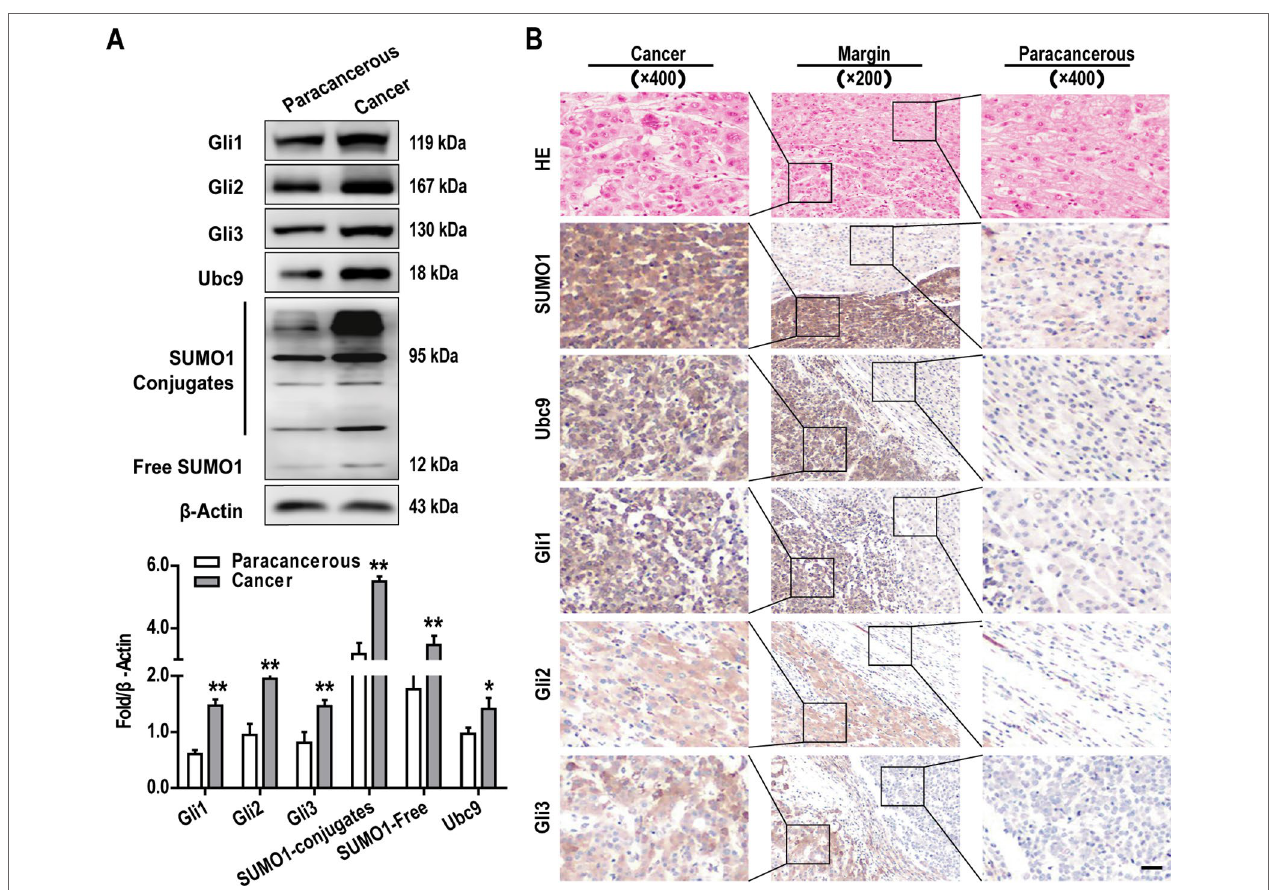
FIGURE 1 | Elevated GLI family proteins expression and extensive protein SUMO modification are characteristics of hepatocellular carcinoma (HCC) cells in vivo . Gli1-3, SUMO1, and Ubc9 protein expressions were examined by (A) western blotting and (B) immunohistochemistry (IHC) (scale bar, 50 µm) in tumors and adjacent normal tissues. Data are shown as means ± SD (n = 3); * P < 0.05 and ** P < 0.01 when compared with adjacent normal tissues (Student’s t